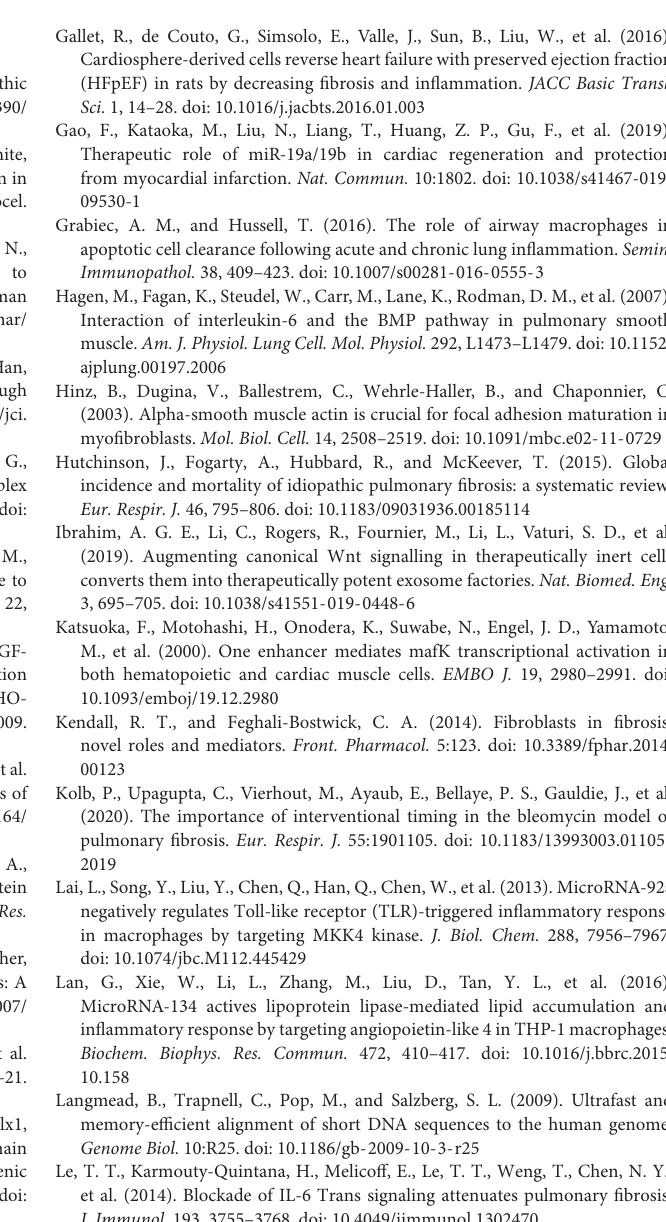
analysis was done using one-way ANOVA with Dunnett’s multiple comparisons test. ∗ p < 0.05, ∗∗ p < 0.01, ∗∗∗ p < 0.001. Supplementary Figure 3 | Cell blood count of animals exposed to bleomycin (vehicle, DF-EVs, and ASTEX) or sham. (A,B) Total white blood cell count, (C,D) neutrophils, and (E,F) monocytes ( n = 5 animals per group). Statistical analysis was done using one-way ANOVA with Dunnett’s multiple comparisons test. Supplementary Figure 4 | Inflammatory cytokine array of mouse lung tissue lysates. Lysates were collected from lung tissue of bleomycin and sham-treated groups 8 days postbleomycin exposure ( n = 4 mice per group). Statistical analysis was done using one-way ANOVA with Tukey’s multiple comparisons